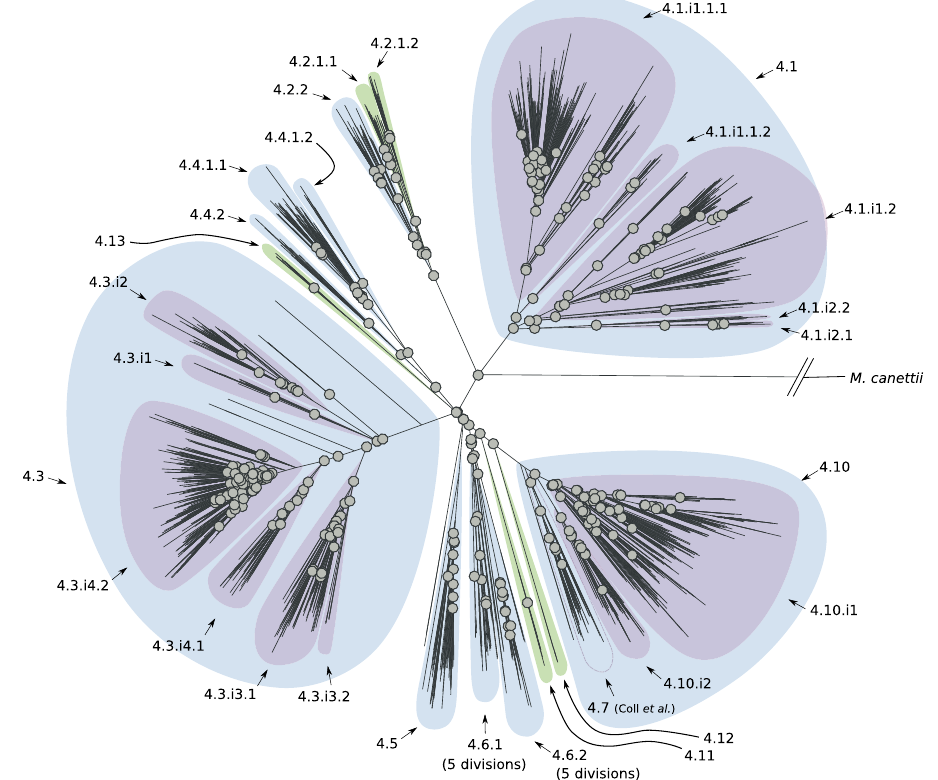
Fig. 4 Phylogenetic tree reconstruction of lineage 4 (binary tree). Gray circles de fi ne splits where the F ST ( fi xation index) calculated using the descendants of the two children nodes is greater than 0.33. The sub-lineages are de fi ned by colored areas (blue: sub-lineages already described in the literature; green: sub-lineages described here; purple: internal sub-lineages). Source data are provided as a Source Data fi le.